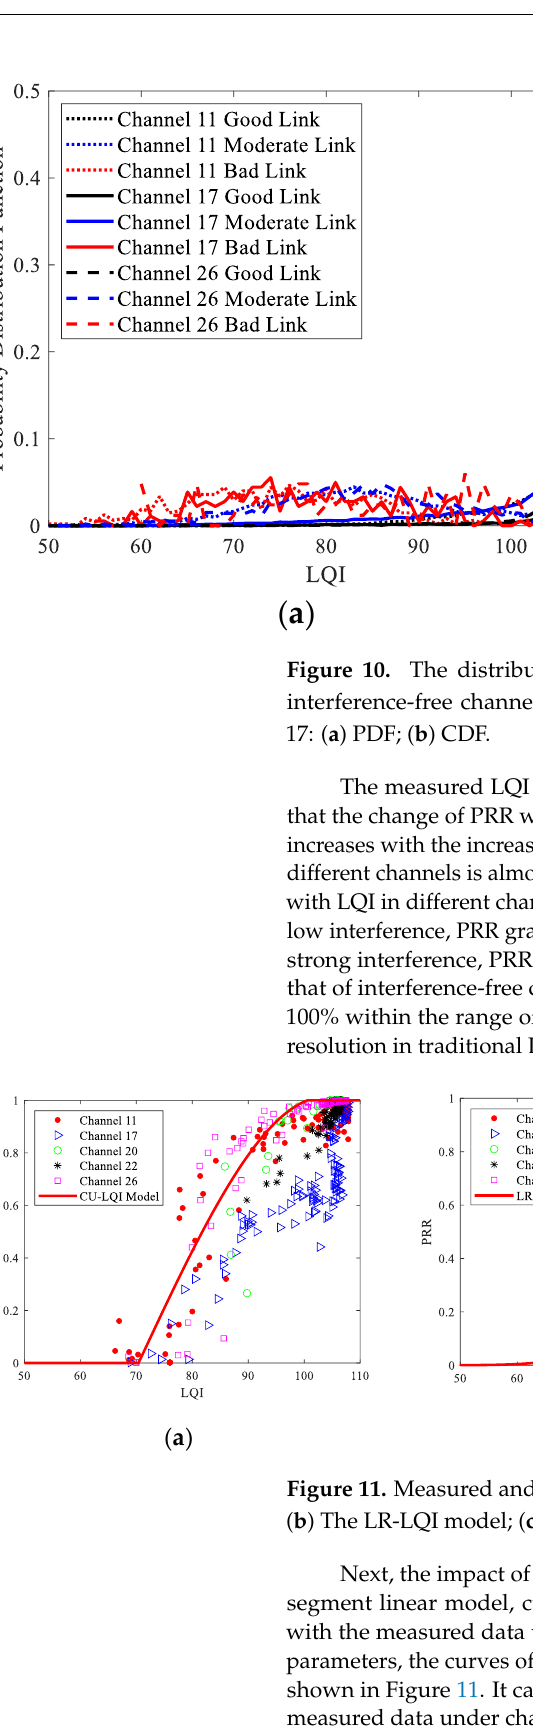
( c ) Figure 11. Measured and Estimated LQI and PRR under different channels: ( a ) The CU-LQI model; ( b ) The LR-LQI model; ( c ) The ML-LQI model.